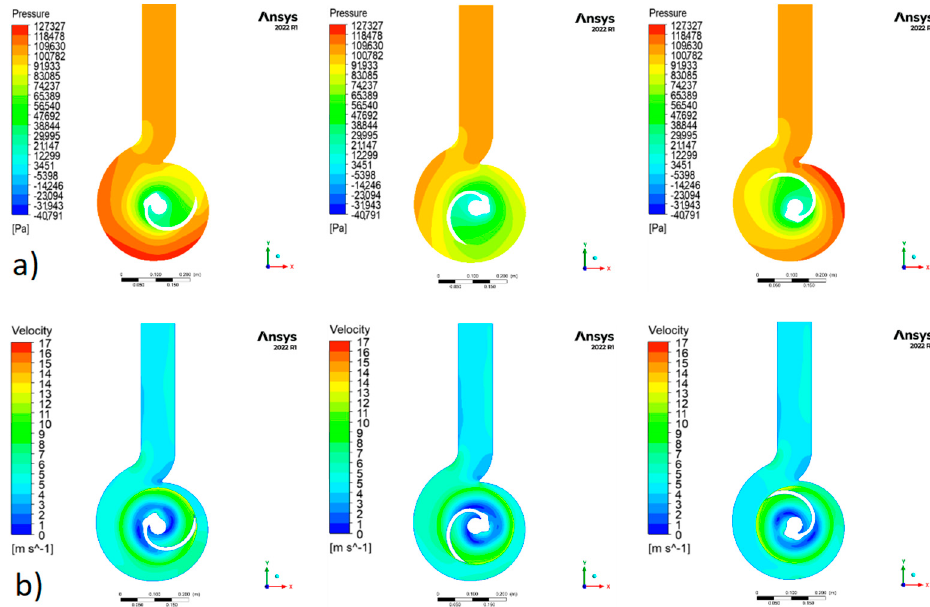
Figure 7. Pressure ( a ) and velocity ( b ) field at 32 l s –1 .